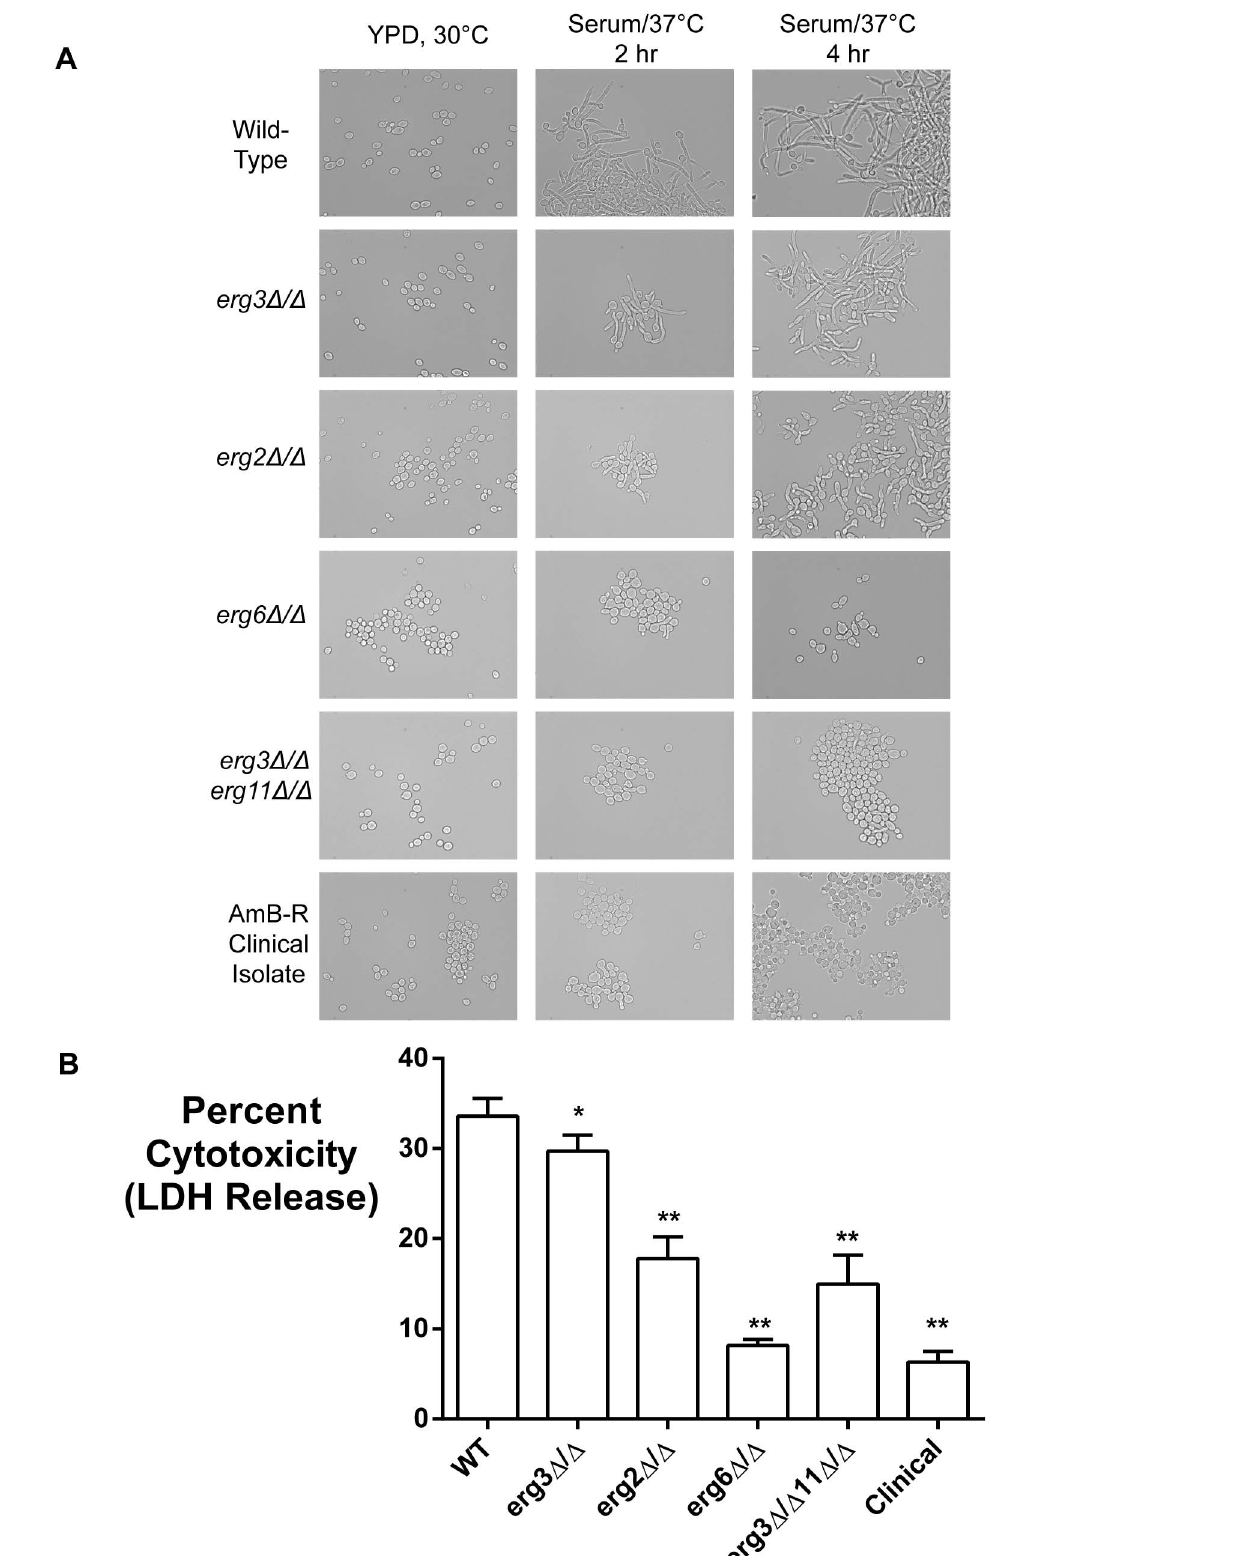
Figure 5. AmB-resistant strains are defective in filamentation and tissue invasion. (A) AmB-resistant mutants fail to properly induce filamentous growth upon stimulation. Wild-type strains and resistant mutants were grown in YPD and then inoculated into RPMI media containing 10% fetal bovine serum at 37 u C. Strains were analyzed by DIC microscopy after 2 and 4 h. (B) AmB-resistant strains cause much less damage to